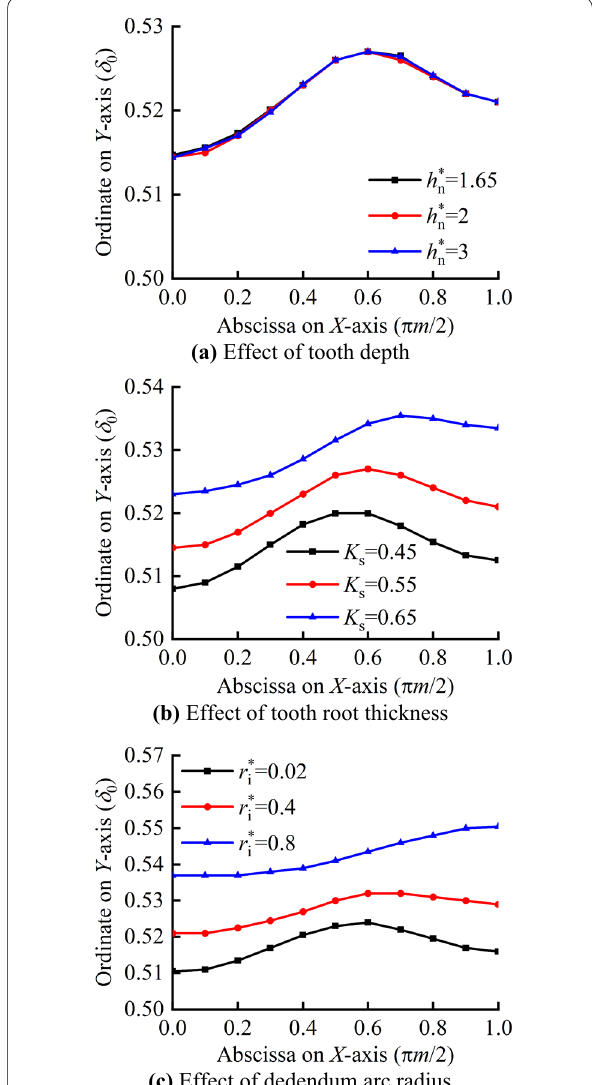
Figure 12 Actual neutral layers of rack with different structures